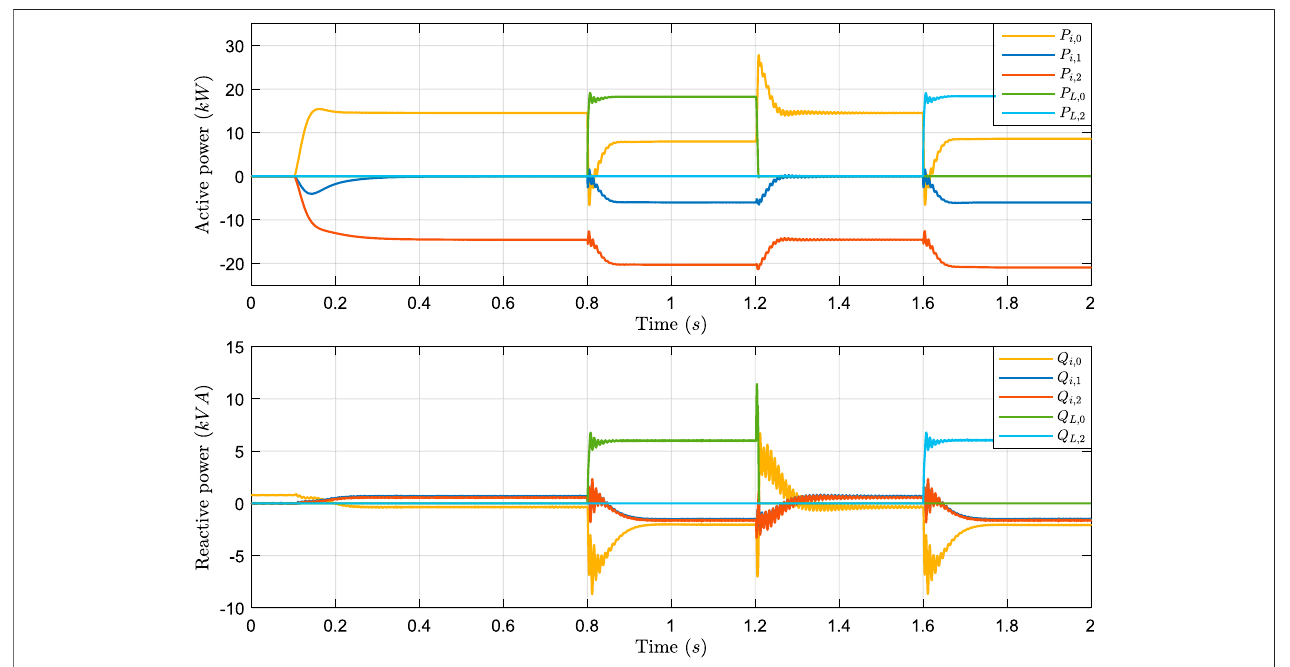
FIGURE 9 | Test two simulation results. Active and reactive power. The SoC of each unit is SoC 0 (cid:2) 35 % , SoC 1 (cid:2) 50 % and SoC 2 (cid:2) 65 % .